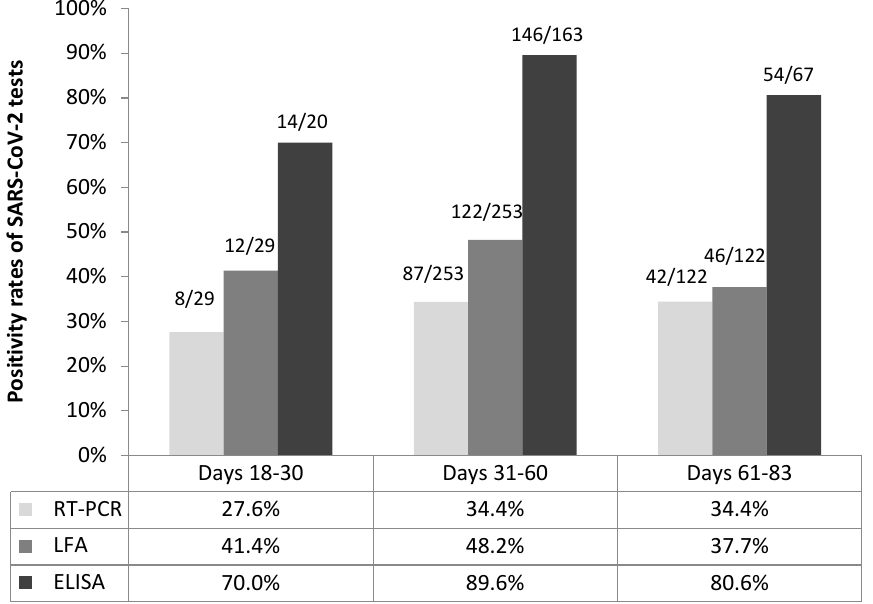
Figure 2. SARS-CoV-2 RT-PCR and antibody positivity rates according to time elapsed since first Figure 2. SARS ‐ CoV ‐ 2 RT ‐ PCR and antibody positivity rates according to time elapsed since first positive SARS-CoV-2 RT-PCR result in first-reported adult cases. Abbreviations: SARS-CoV-2, severe positive SARS ‐ CoV ‐ 2 RT ‐ PCR result in first ‐ reported adult cases. Abbreviations: SARS ‐ CoV ‐ 2, severe acute respiratory syndrome coronavirus 2; RT ‐ PCR, reverse ‐ transcriptase polymerase chain reaction; acute respiratory syndrome coronavirus 2; RT-PCR, reverse-transcriptase polymerase chain reaction; LFA, immunochromatographic lateral flow assay; ELISA, enzyme ‐ linked immunosorbent assay. LFA, immunochromatographic lateral flow assay; ELISA, enzyme-linked immunosorbent assay. Comparable rates of nasopharyngeal SARS ‐ CoV ‐ 2 RNA persistence were observed Table 2. Factors associated with persistent nasopharyngeal SARS-CoV-2 RNA detection in first-reported adult cases. according to results of LFA: 64/180 (35.6%) in LFA ‐ positive adults and 73/224 (32.6%) in